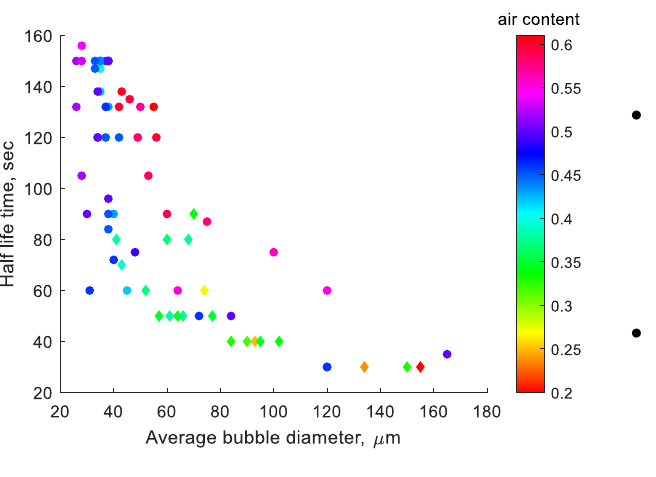
Fig. 9 Half-life time as a function of average bubble diameter for pure foam (spheres) and fiber foam (diamonds). Air content is shown with colours